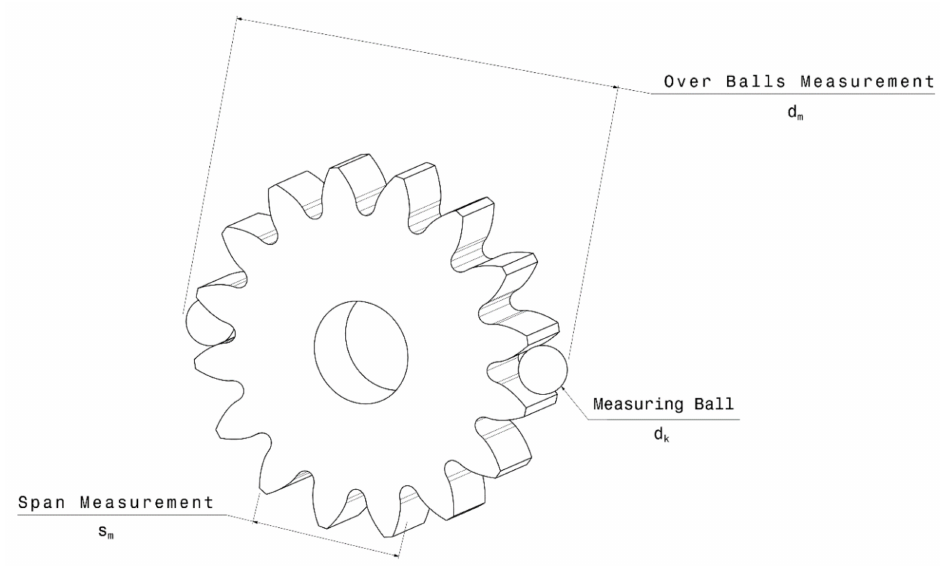
Figure 1. A schematic view of span measurement and over-balls measurement for a